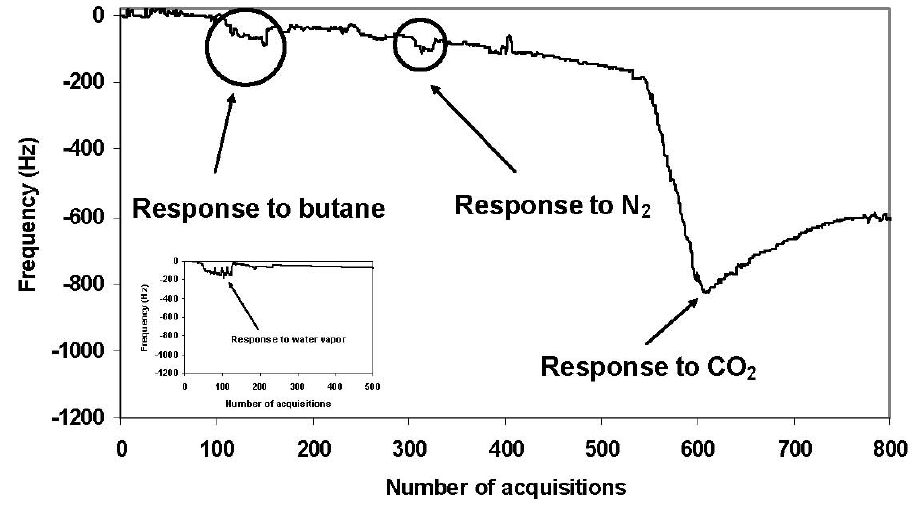
, and CO , respectively. Experimental data showed the sensor 2 2 , while other gases were not 2